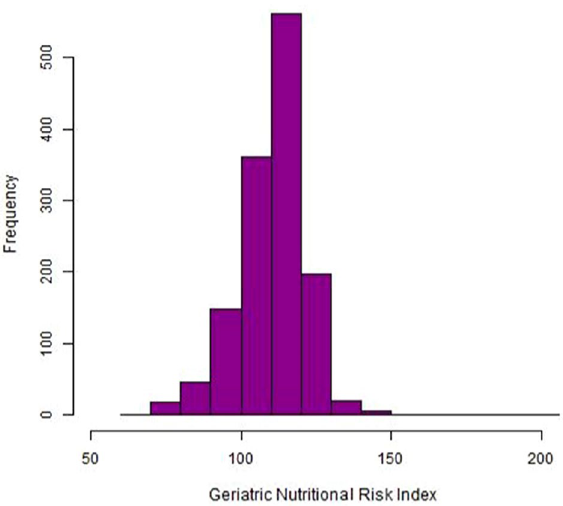
Figure 1. GNRI distribution of the study